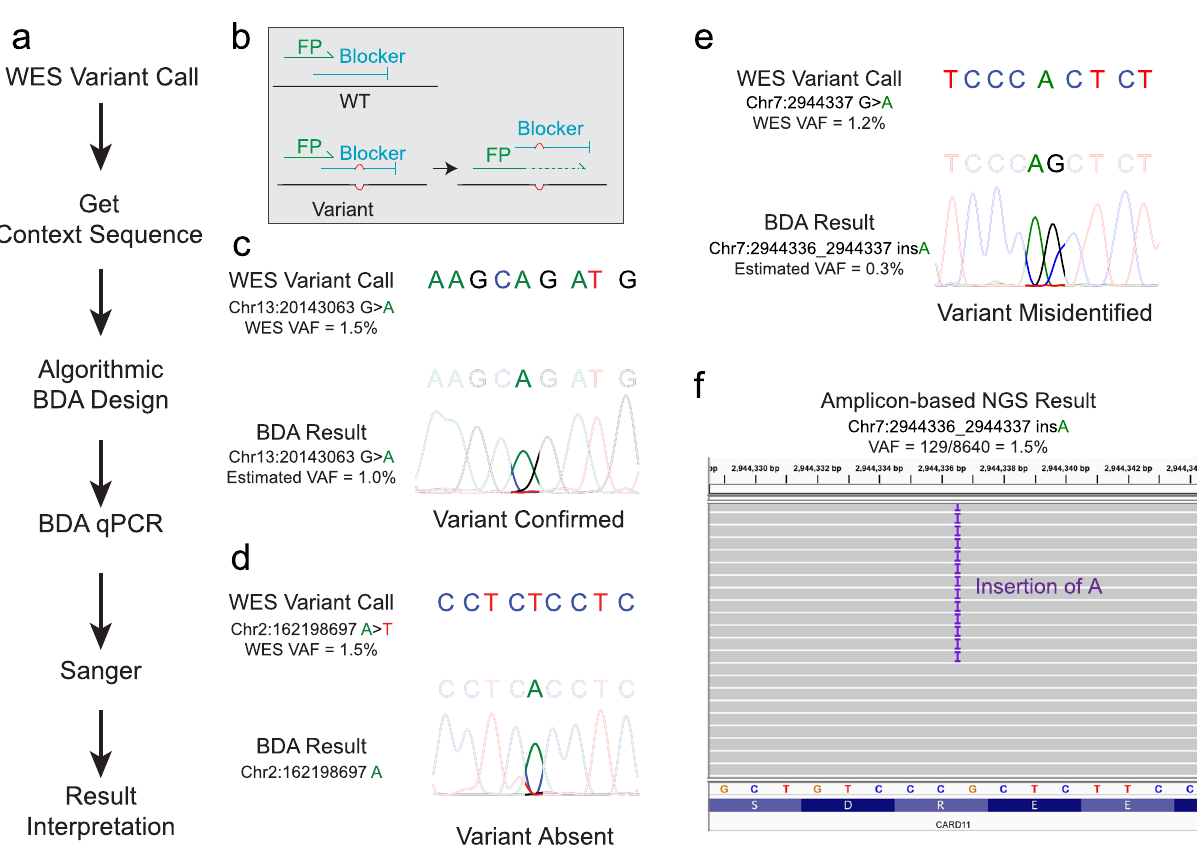
Figure 2. WES variant confirmation using Blocker Displacement Amplification (BDA). ( a ) Workflow for BDA confirmation of WES variants. ( b ) Mechanism for BDA variant enrichment 16 . The blocker preferentially binds to wildtype (WT) DNA sequences and suppresses their PCR amplification, resulting in selective amplification of variants. FP, forward primer. ( c ) Example 1: WES-called variant confirmed by BDA. ( d ) Example 2: Locus of interest was identified as wildtype by BDA, indicating that the variant called by WES was absent in the sample. ( e ) Example 3: Locus of interest showing a peak with an insertion rather than the WES-called substitution, indicating that the variant was misidentified by WES. ( f ) The amplicon-based NGS result (Integrative Genomics Viewer) for variants in ( e ) matches the BDA sequencing; BDA qPCR/Sanger is sufficiently accurate. Amplicon-based sequencing experiments in this study were used only to validate our method. For loci where somatic variants are detected, the mean depth was 527 × in fresh-frozen sample and 131 × in FFPE sample (Fig. 3a). Of the 155 somatic variants in fresh-frozen sample and 2852 somatic variants in FFPE sample with < 5% VAF in WES, the mean depth was 824 × for fresh-frozen sample (ranging from 95 × to 2585 ×) and 243 × for FFPE sample (1 × to 1570 ×). Although both samples were sequenced for more than 1000 × , the actual sequencing depth of FFPE-detected variants is significantly less. This may be caused by the uneven cov- erage of FFPE-derived DNA, primarily attributed to short fragment length. For fresh-frozen sample, 842 M raw reads were obtained, where 535 M (63.7%) were unique reads and target bases above 20 × were 97.3%. For FFPE sample, 857 M raw reads were obtained, where 181 M (21.1%) were unique reads and target bases above 20 × were 71.9%. Among the 226 WES-detected low-level variants undergoing confirmatory BDA qPCR/Sanger analysis, the overall disconfirmed rate was 52% (117/226, Table 1). 35% (33/94) in fresh-frozen sample and 64% (84/132) in FFPE sample were disconfirmed. This indicates a high false-positive rate of WES in detecting low-level variants. In the 66 cancer-related variants, the disconfirmed rate was as high as 82% (54/66, Table 1). The confirmed cancer-related variants by this study are listed in Table 2 (Sanger traces in Supplementary Fig. S1-S2). The 12 confirmed variants include 10 substitutions, 1 small deletion (2-bp deletion in dinucleotide repeats) and 1 large deletion (62-bp deletion). Confirmatory results for all 226 variants are listed in Supplementary Table S1. In fresh-frozen sample, variants > 3% VAF show a better confirmed rate (87%), compared to that of vari- ants ≤ 3% VAF (50%). While in FFPE sample, all VAF brackets have a low confirmed rate (overall 36%) (Fig. 3b). This is likely due to the sequencing depth differences. Among the 155 somatic low-level variants from fresh- frozen sample (mean depth 824 ×), we unbiasedly selected 94 variants for BDA analysis. The mean depth for selected variants was 774 × , with minimal depth 95 × . All variants had at least 4 variant reads in WES. Among the 2852 somatic low-level variants from FFPE sample (mean depth 243 ×), we unbiasedly selected 132 variants for BDA analysis. The mean depth for selected variants was 200 × , with minimal depth 43 × . 131/132 variants